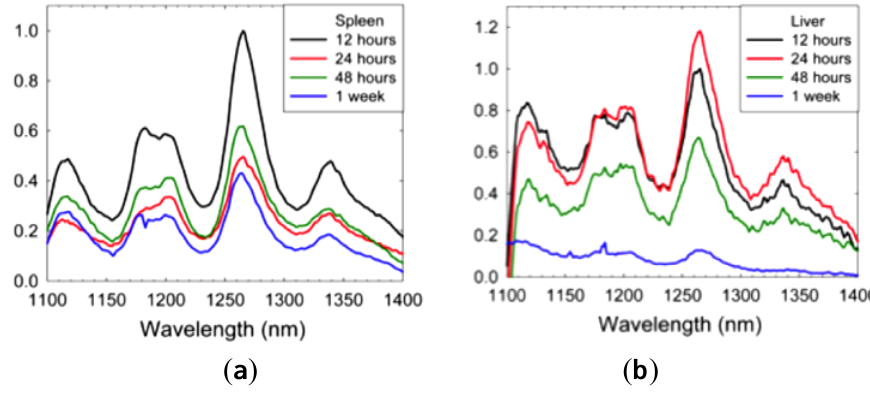
Figure 10. Relative SWCNT content in ( a ) spleen and ( b ) liver at 12, 24, 48 h and 1 week after mice received single bolus of 100 µg SWCNT solubilized in 3% pluronic displayed by fluorescence